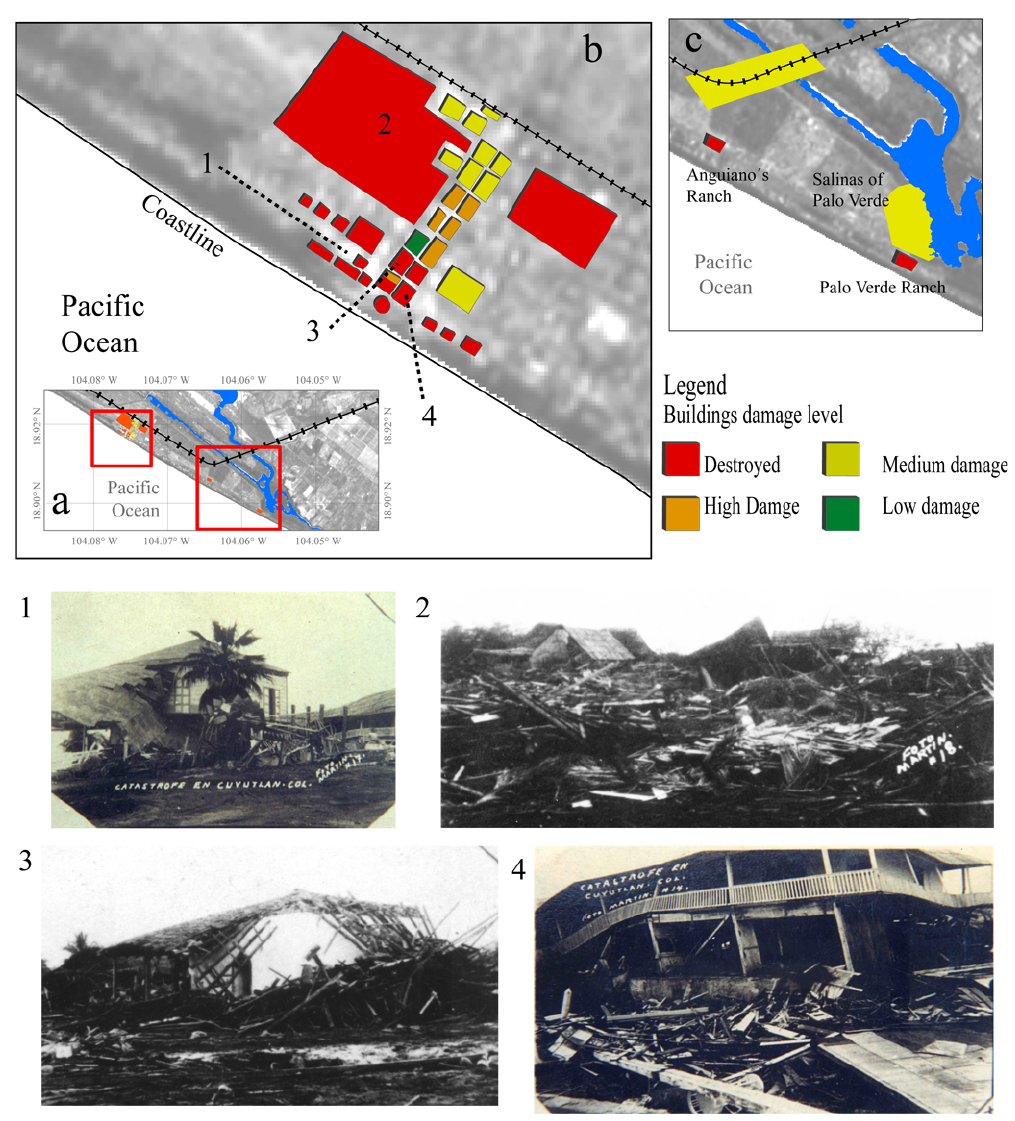
Fig. 9. Direct effects and building damage level map. (a) Cuyutl´an, Colima map. Squares show the most affected zones, (b) most affected zone at Cuyutl ´ an and damage level on each building. (1) Aguayo’s Chalet, (2) view to destroyed houses, (3) Hotel Santa Cruz #1 (El Informador 1932c), and (4) Hotel Ceballos. (c) The settlements of Anguino’s Ranch and Palo Verde Ranch completely destroyed, railroad section with medium damage level and medium damaged Salinas of Palo